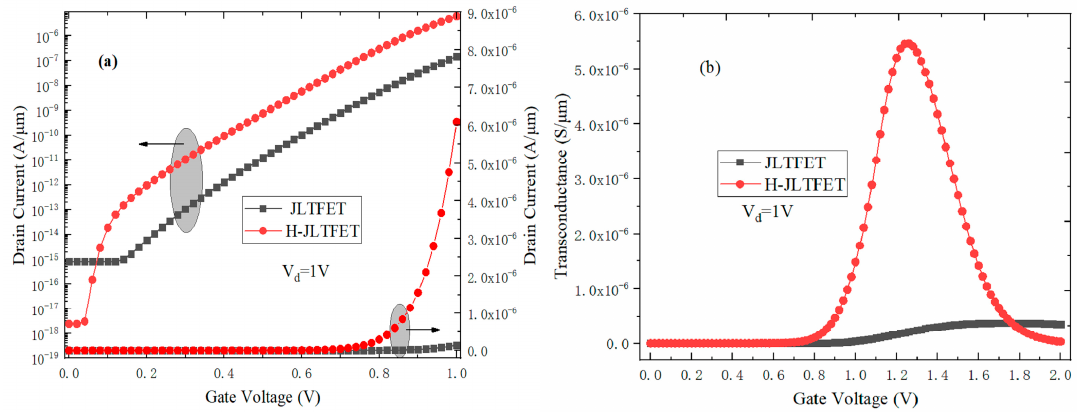
Figure 2. ( a ) Transfer characteristics; and ( b ) transconductance of JLTFET and